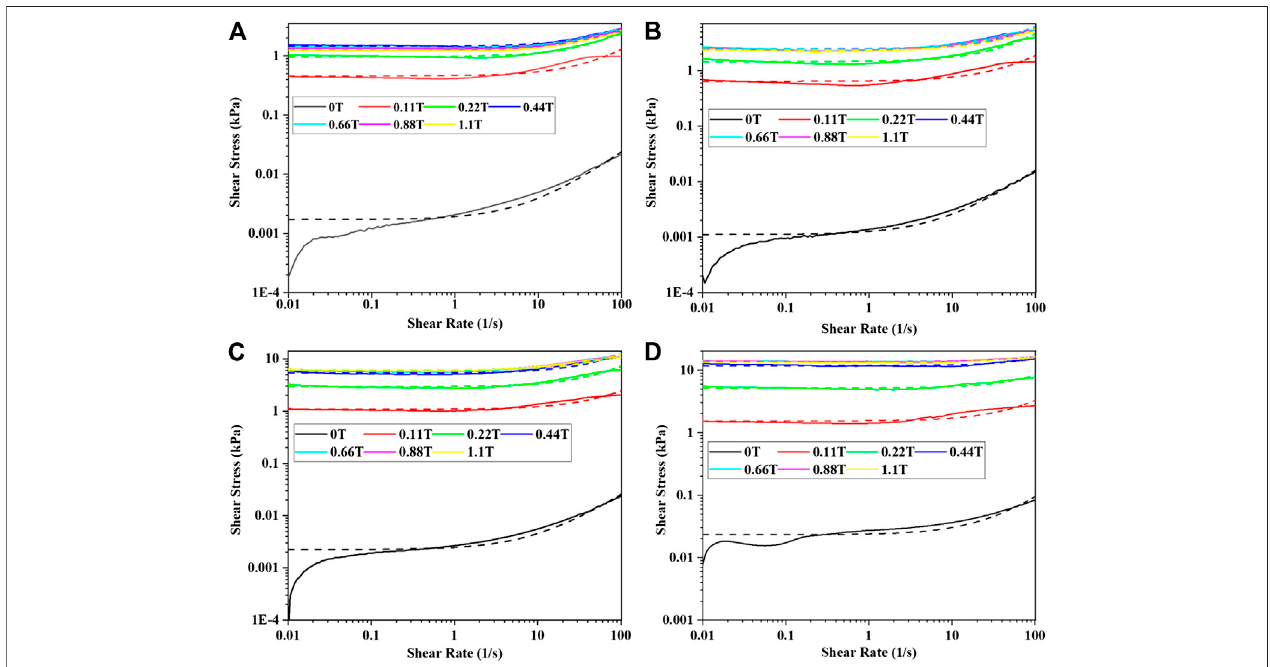
FIGURE 4 | Experimental and fi tting curve of shear rate vs. shear stress: (A) 40%, (B) 50%, (C) 60%, and (D) 70%.